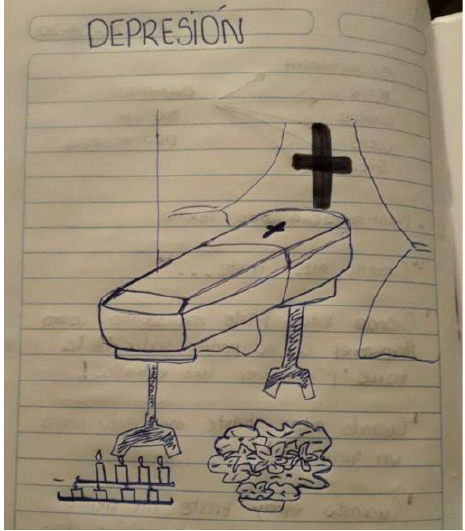
Figure 5. Drawing of death as a representation of depression by a young adult. Other events identified as anxiety and depression symptom triggers included migra- tion or changing houses and being physically distant from relatives. Situations related to difficulties in the relationship with parents such as constant arguments or distant relation- ships were also linked to depressive symptoms for both age groups (see Figure 6).